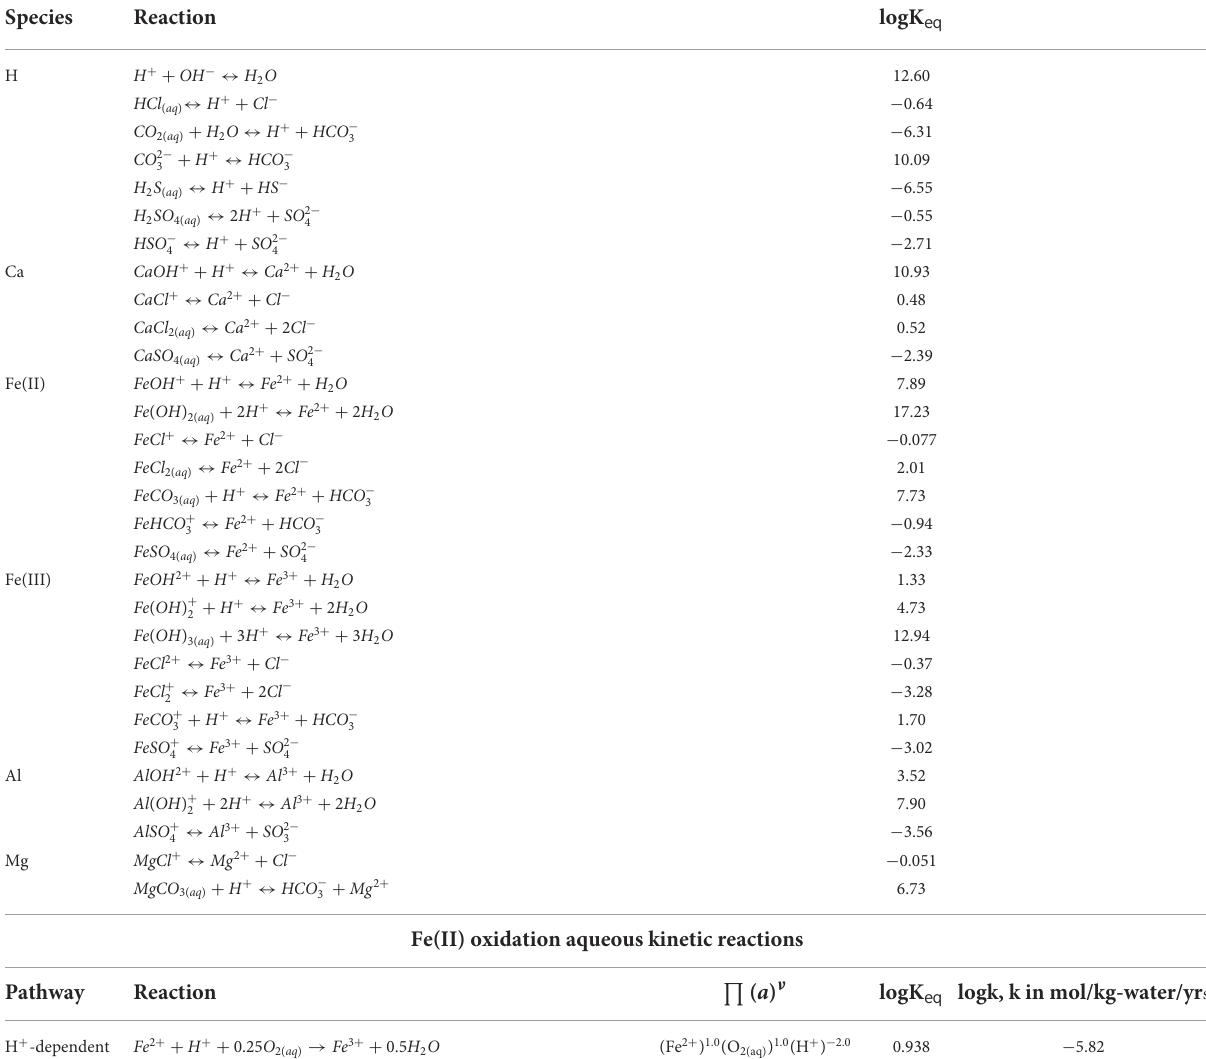
TABLE 4 Reaction network in the